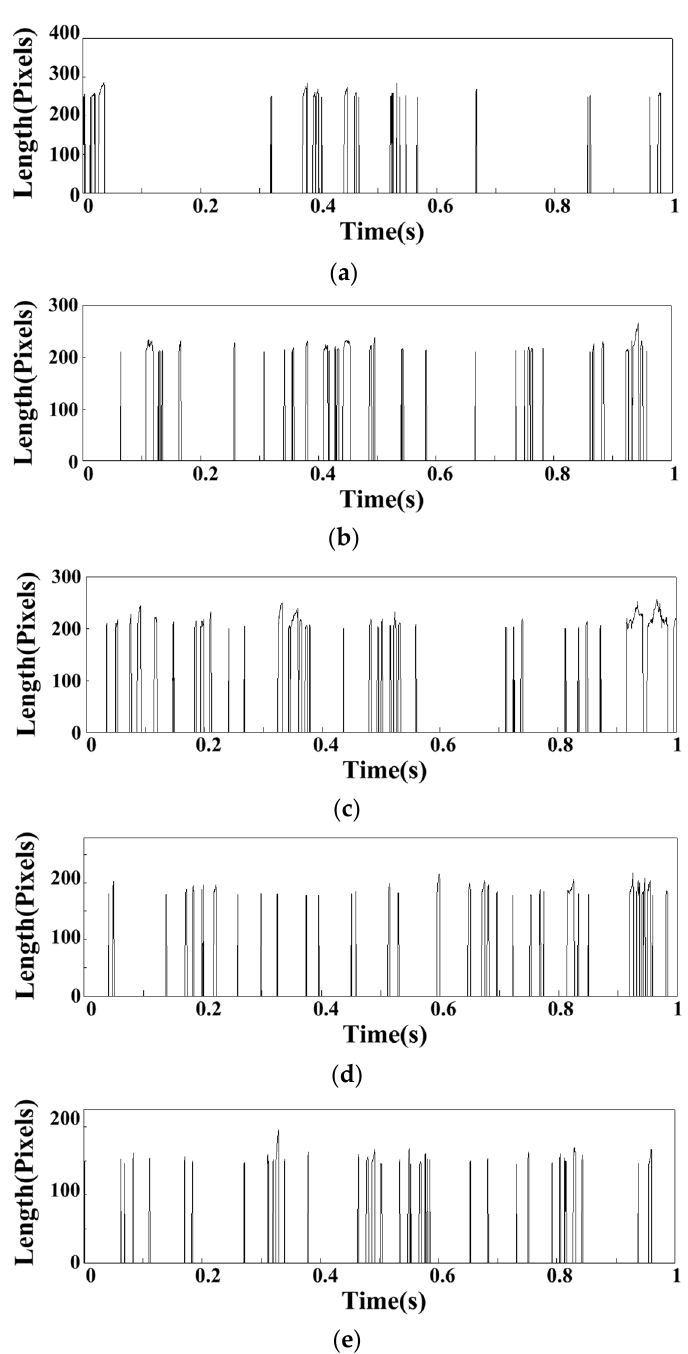
Figure 12. Statistics of flame shedding under operating conditions of group MA: ( a ) MA01; ( b ) MA02; ( c ) MA03; ( d ) MA04; ( e ) MA05.